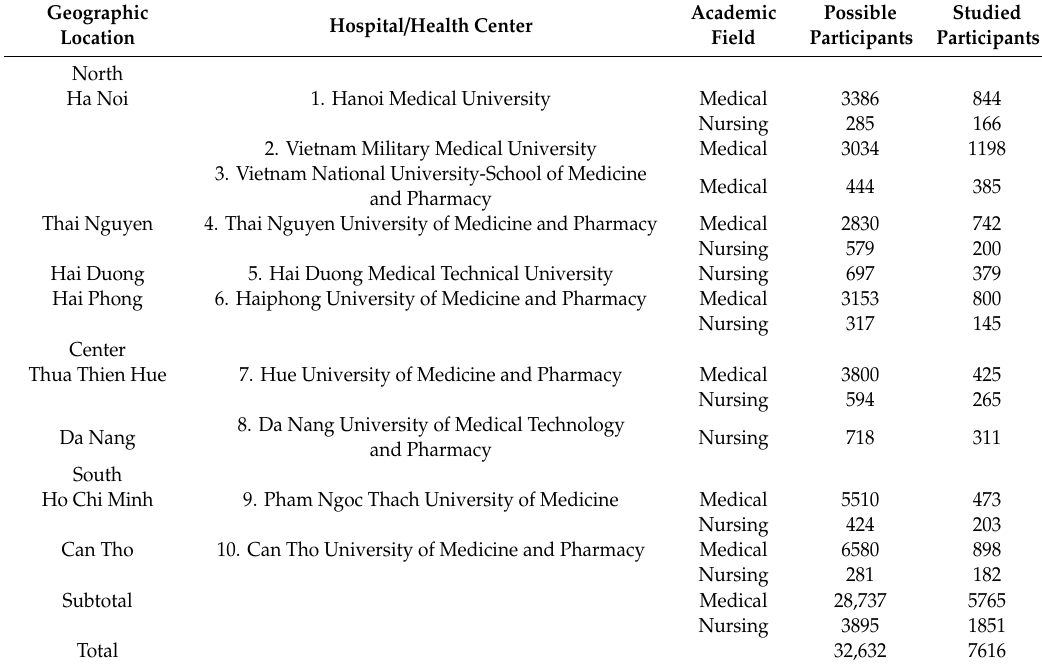
Table 1. Study participants in di ff erent universities by geographic